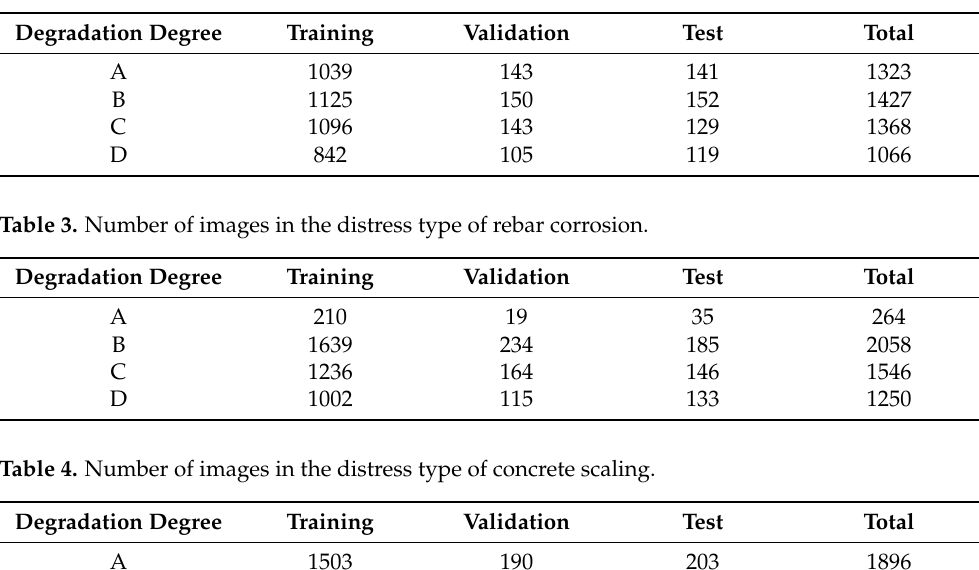
Table 2. Number of images in the distress type of efflorescence.